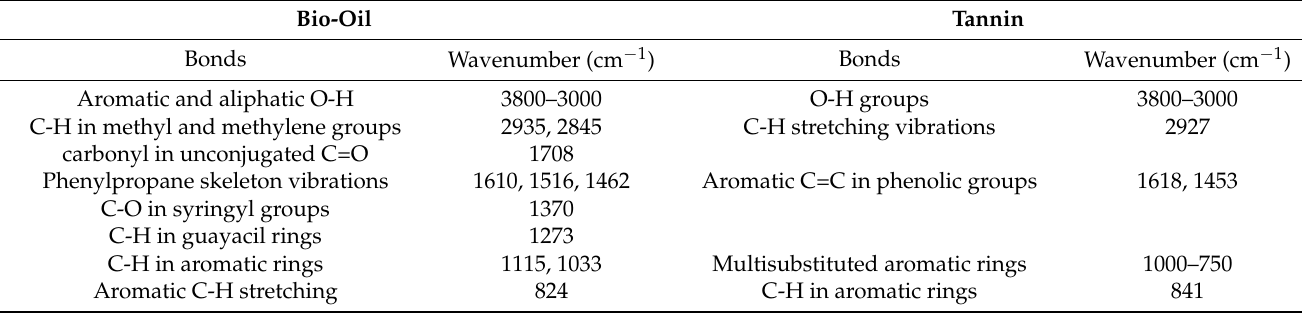
Table 1. Chemical groups obtained from FTIR analysis of bio-oil and tannin.